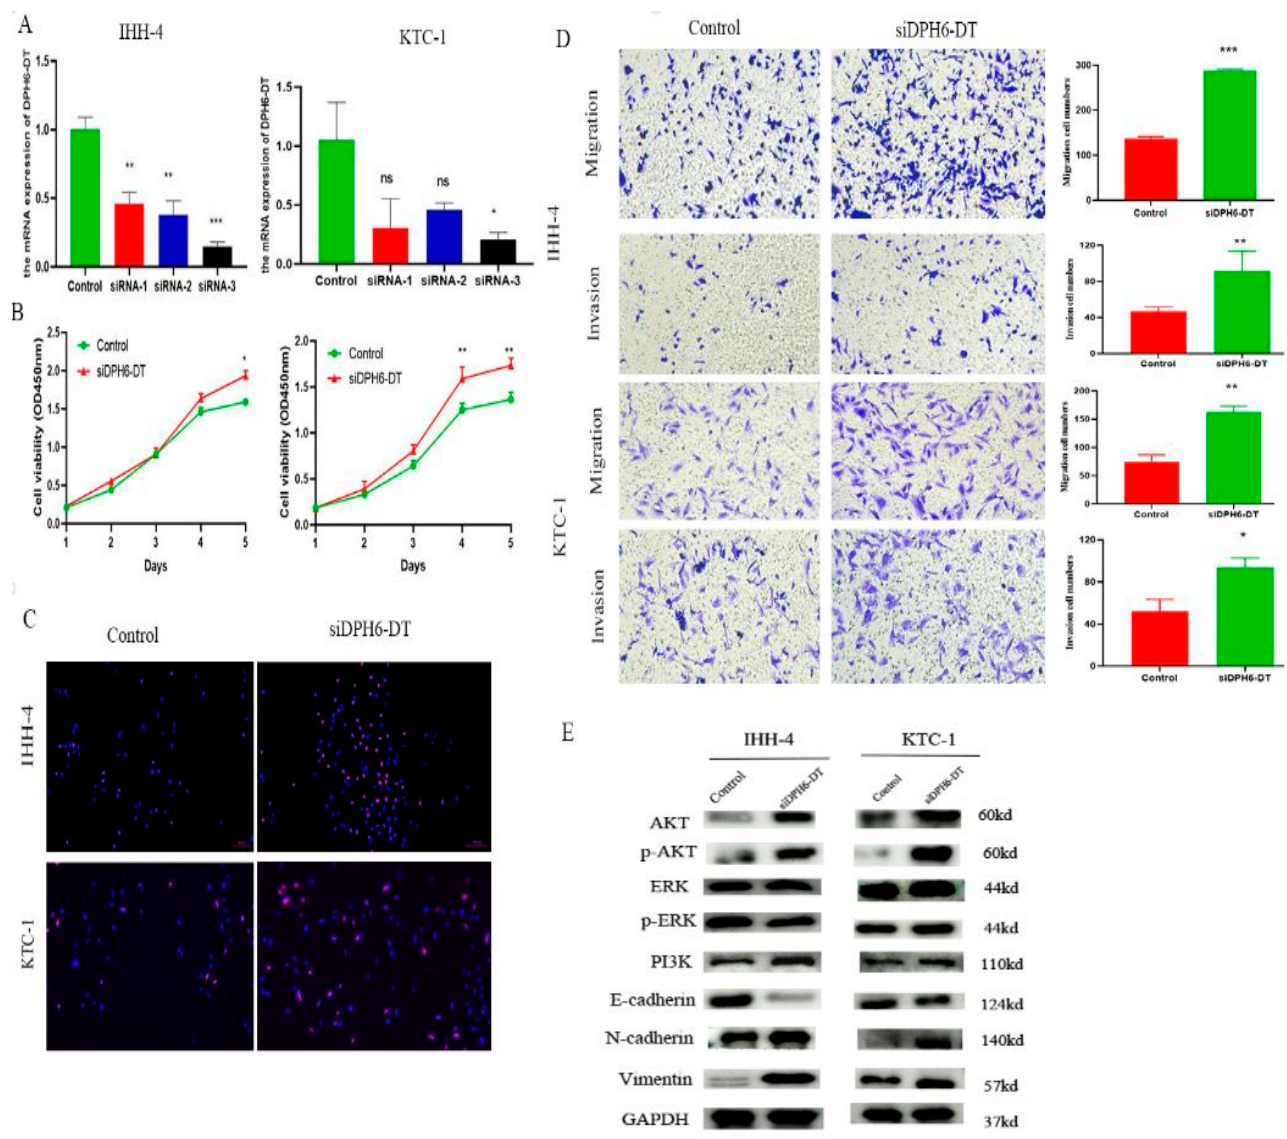
Figure 8. Depletion of DHP6 ‐ DT promoted proliferation and metastasis by activating the PI3K ‐ AKT signaling pathway. ( A ) IHH ‐ 4 and KTC ‐ 1 cells were transfected with different si DPH6 ‐ DT and scramble vector (control). ( B ) Knockdown of DPH6 ‐ DT enhanced cell viability by CCK ‐ 8 assay. ( C ) Deficiency of DPH6 ‐ DT dramatically increased cell proliferation by EdU assay. ( D ) Knockdown of DPH6 ‐ DT accelerated cell migration and invasion. ( E ) Western blot for the EMT and PI3K ‐ AKT signal pathway related protein expression upon the knockdown of DPH6 ‐ DT. EMT: epithelial ‐ mesenchymal transition. *** p < 0.001, ** p < 0.01, and * p < 0.05.